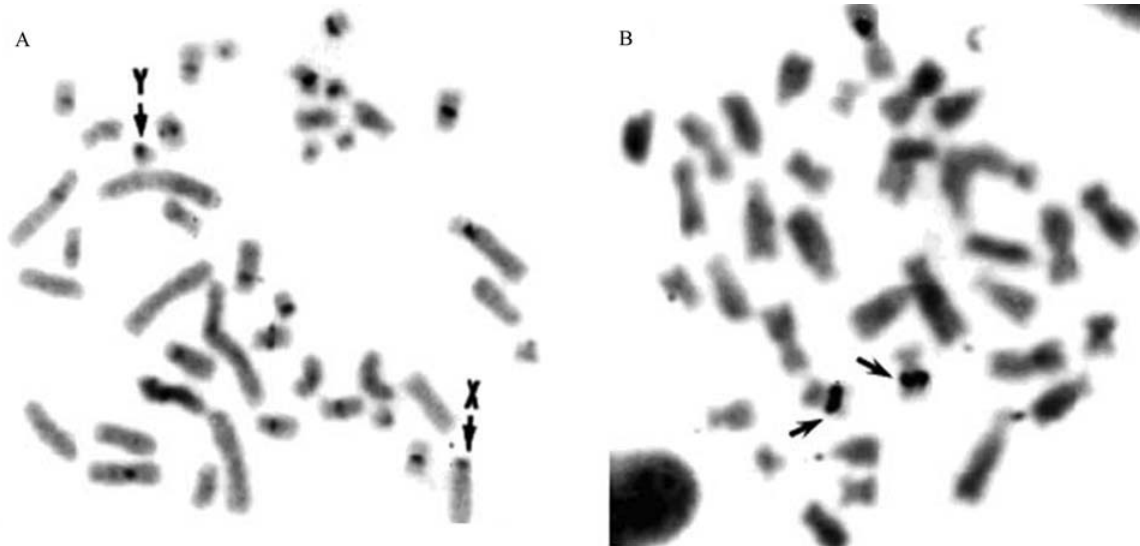
Figure 2 - Metaphases of Callistomys pictus after: (A) CBG-banding, arrows indicate the X and Y chromosomes and (B) Ag-NORs, arrows indicate the NOR-bearing pair